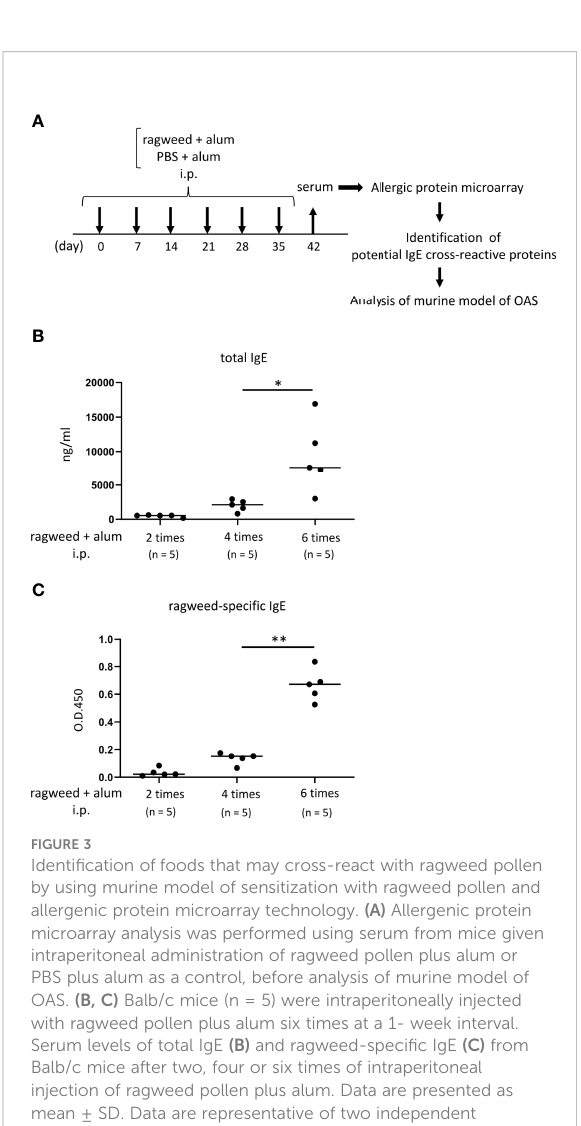
inside the lower lip. The results showed that signi fi cantly higher amounts of dye extravasation were evident in ragweed-sensitized mice injected with black pepper extract but not with PBS (Figure 4E). In accordance with this, histological analyses of the inside of the lower lip revealed frequent distribution of degranulated mast cells in the former mice, but not in the latter mice (Figure 4F). It should be noted that the injection of black pepper extract or PBS did not induce apparent dye extravasation in the non-sensitized control mice (Figure 4E). Collectively, these results indicate that black pepper allergen crosslinked ragweed-speci fi c IgE-bound Fc e RI on mast cells, leading to mast cell degranulation inside the lower lip. Thus, we were able to provide evidence of IgE cross-reactivity between ragweed pollen and black pepper in murine model.